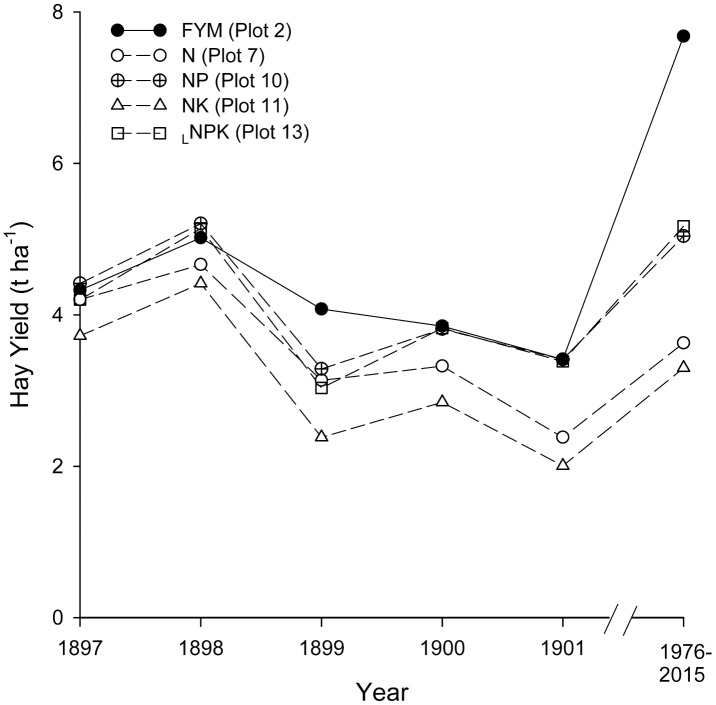
Changes in mean hay yield at Palace Leas for the FYM (20 t ha-1) and four ammonium sulphate-containing fertilizer treatments for the first 5 years of the experiment (1897–1901) and the more recent long-term average (1976–2015).